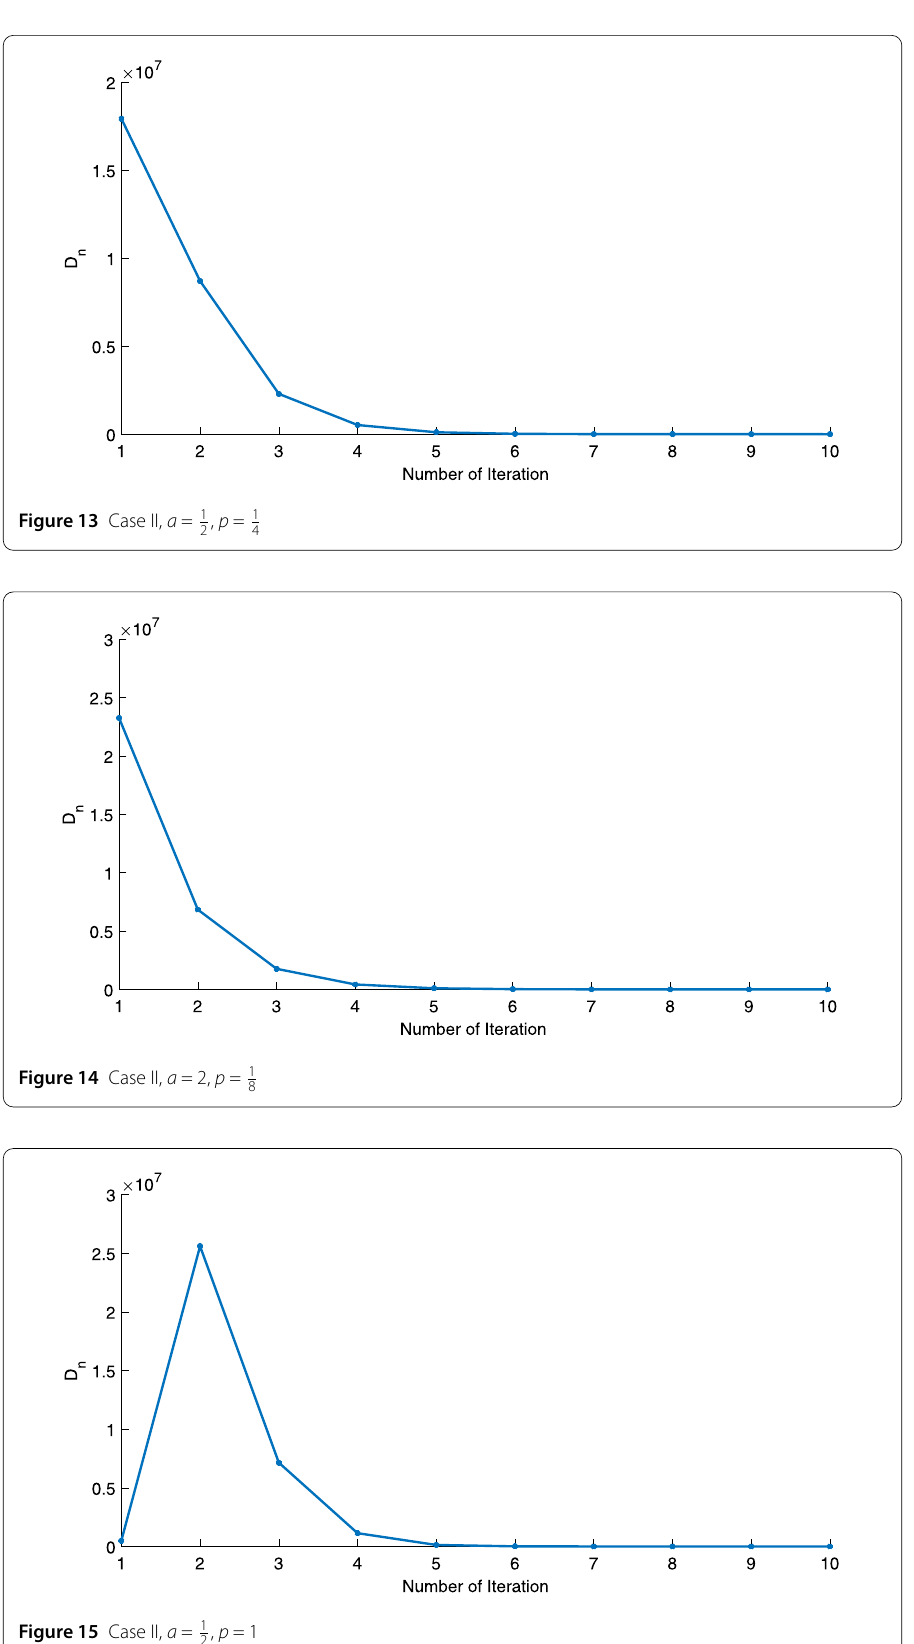
Figure 15 Case II, a = 1